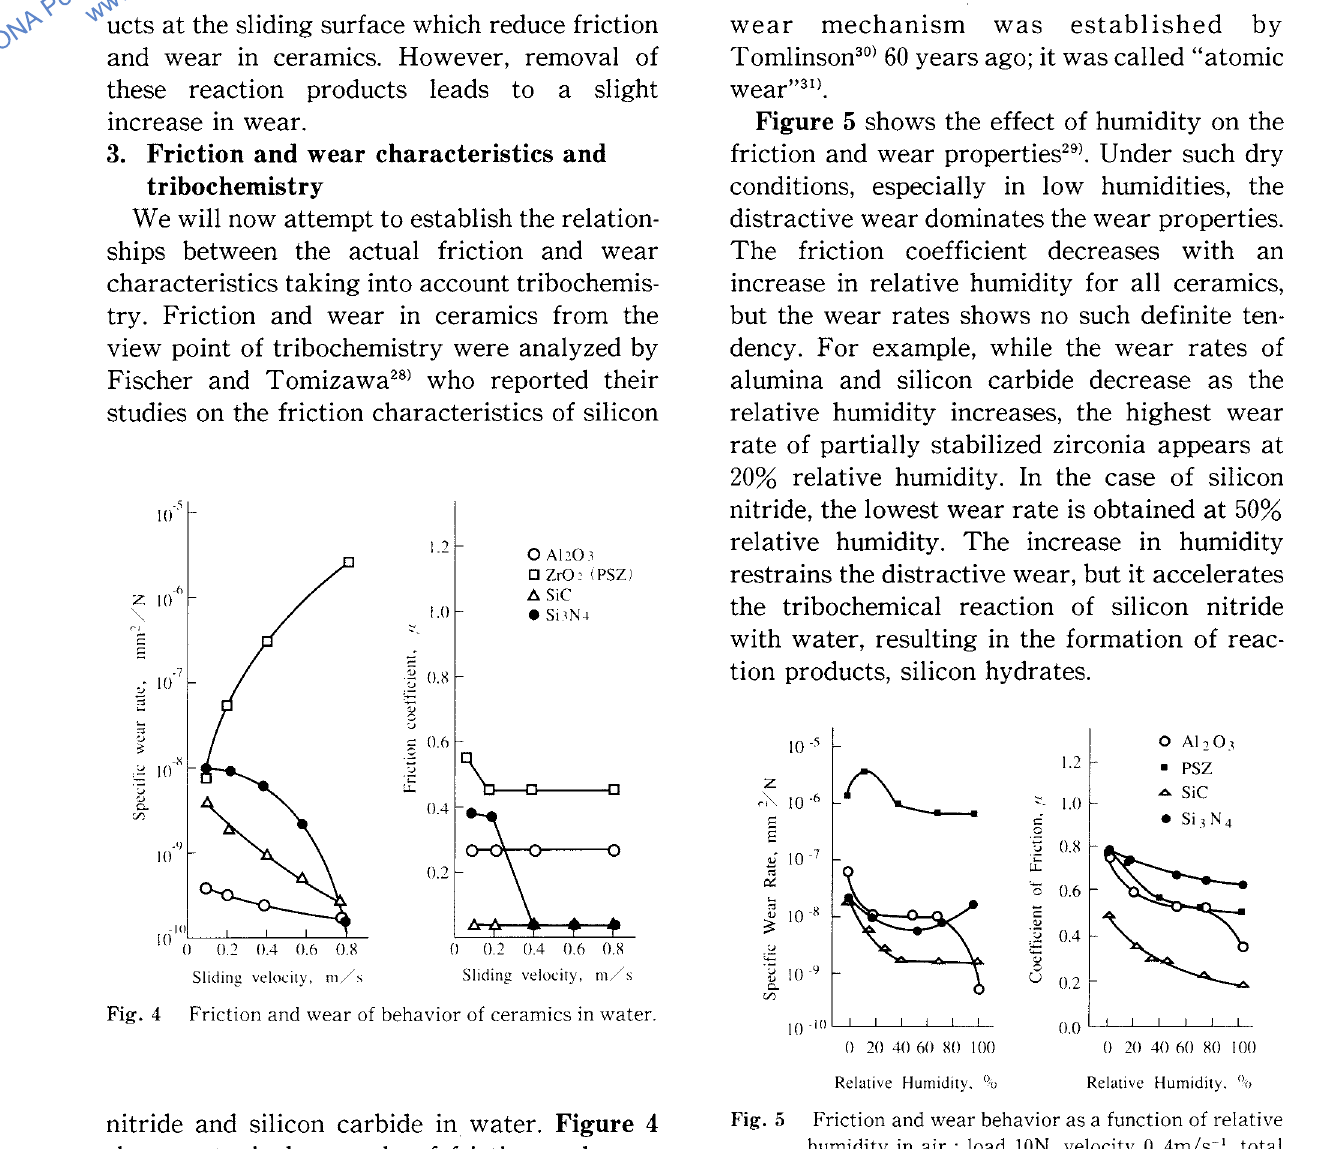
Fig. 4 Friction and wear of behavior of ceramics in water.